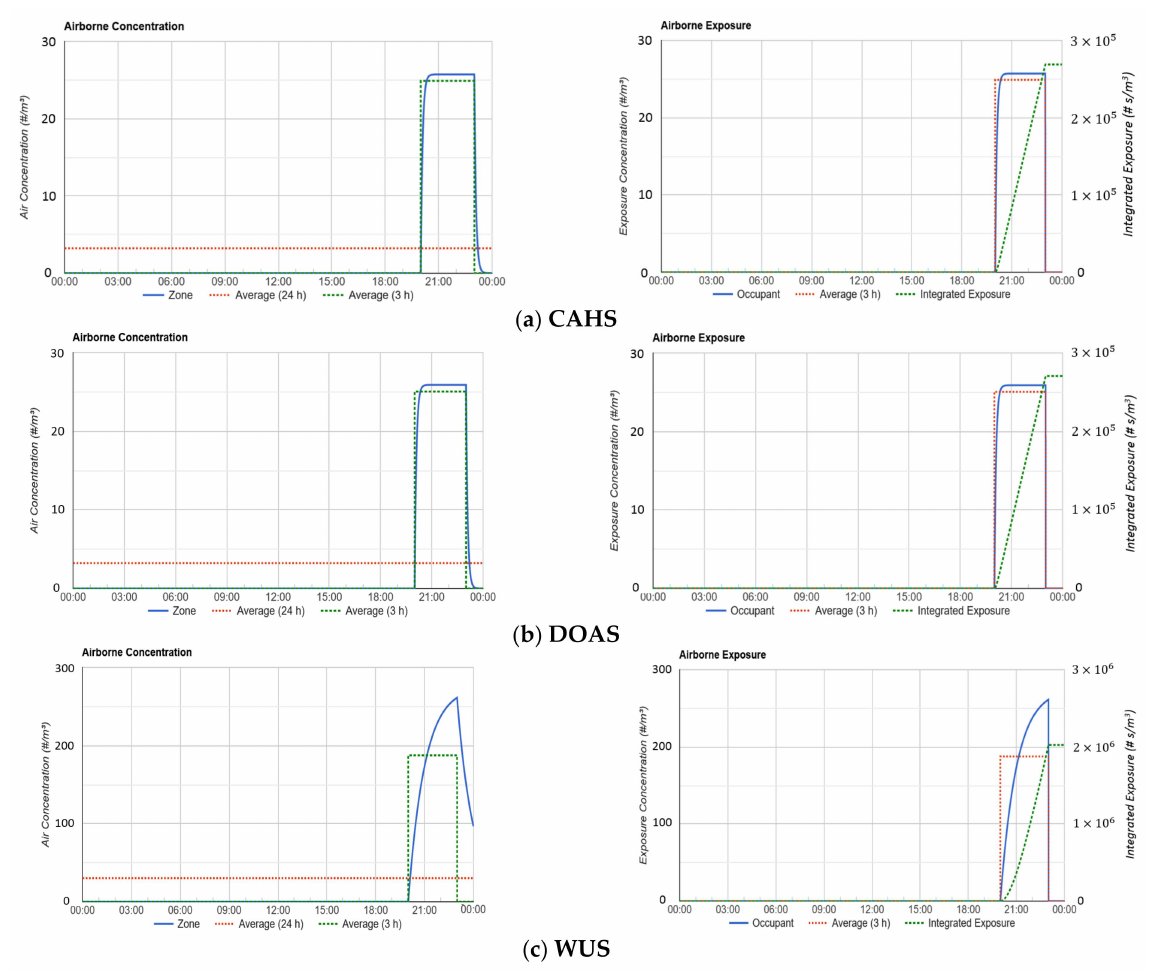
Figure A2. Transient aerosol airborne concentration and exposure within the 24 h for a highly occupied indoor space served by three different HVAC